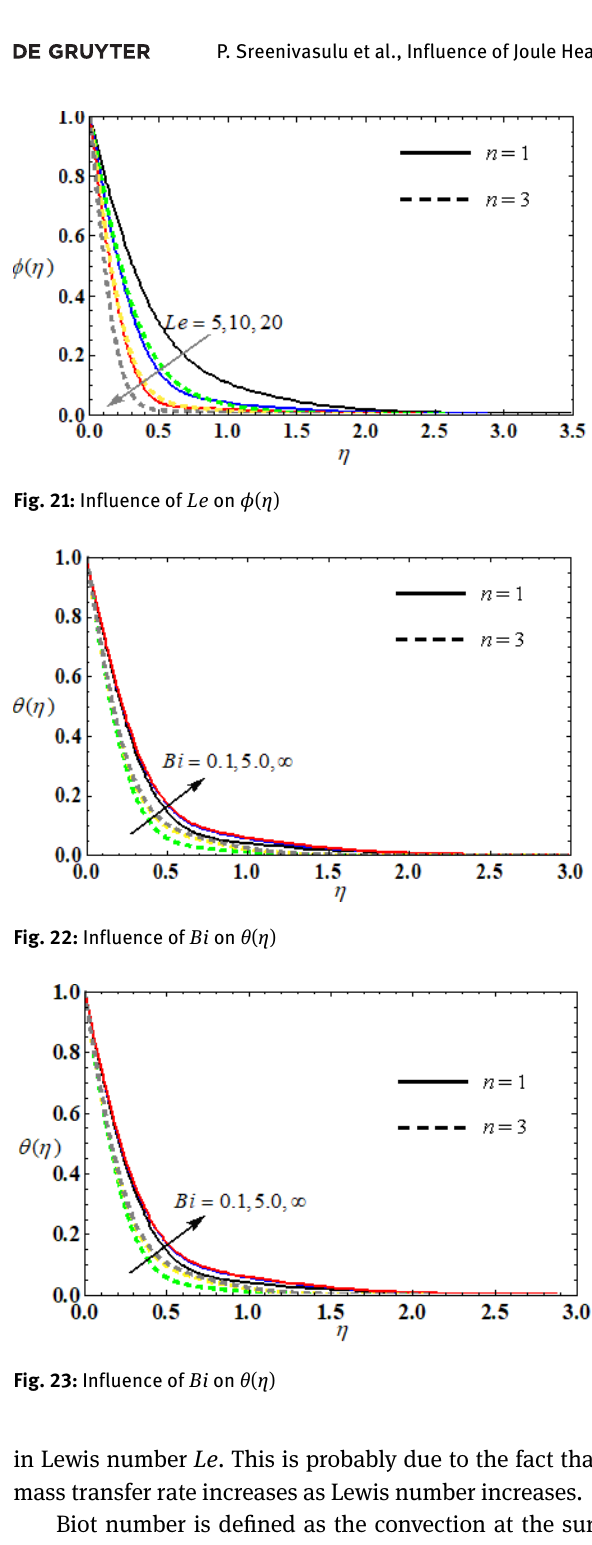
body. Temperature and concentration profiles versus Biot number Bi is depicted in Figures 22 and 23